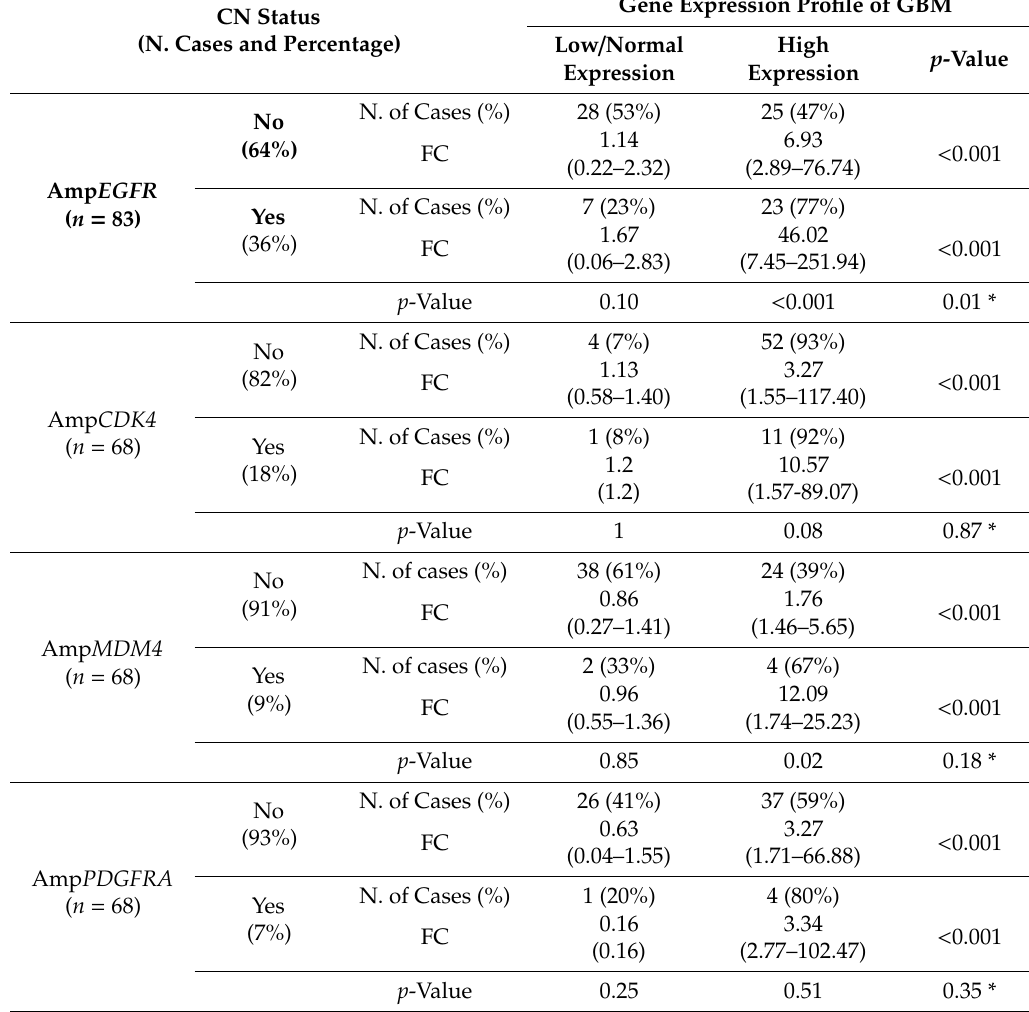
Table 3. Association between the copy number (CN) status and gene expression profile of the EGFR , CDK4 , MDM4 , and PDGFRA genes in